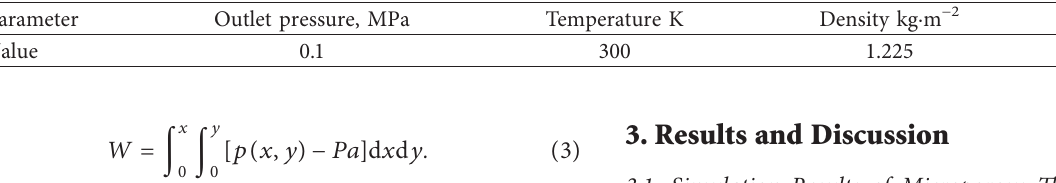
Table 1: Model simulation environment variable